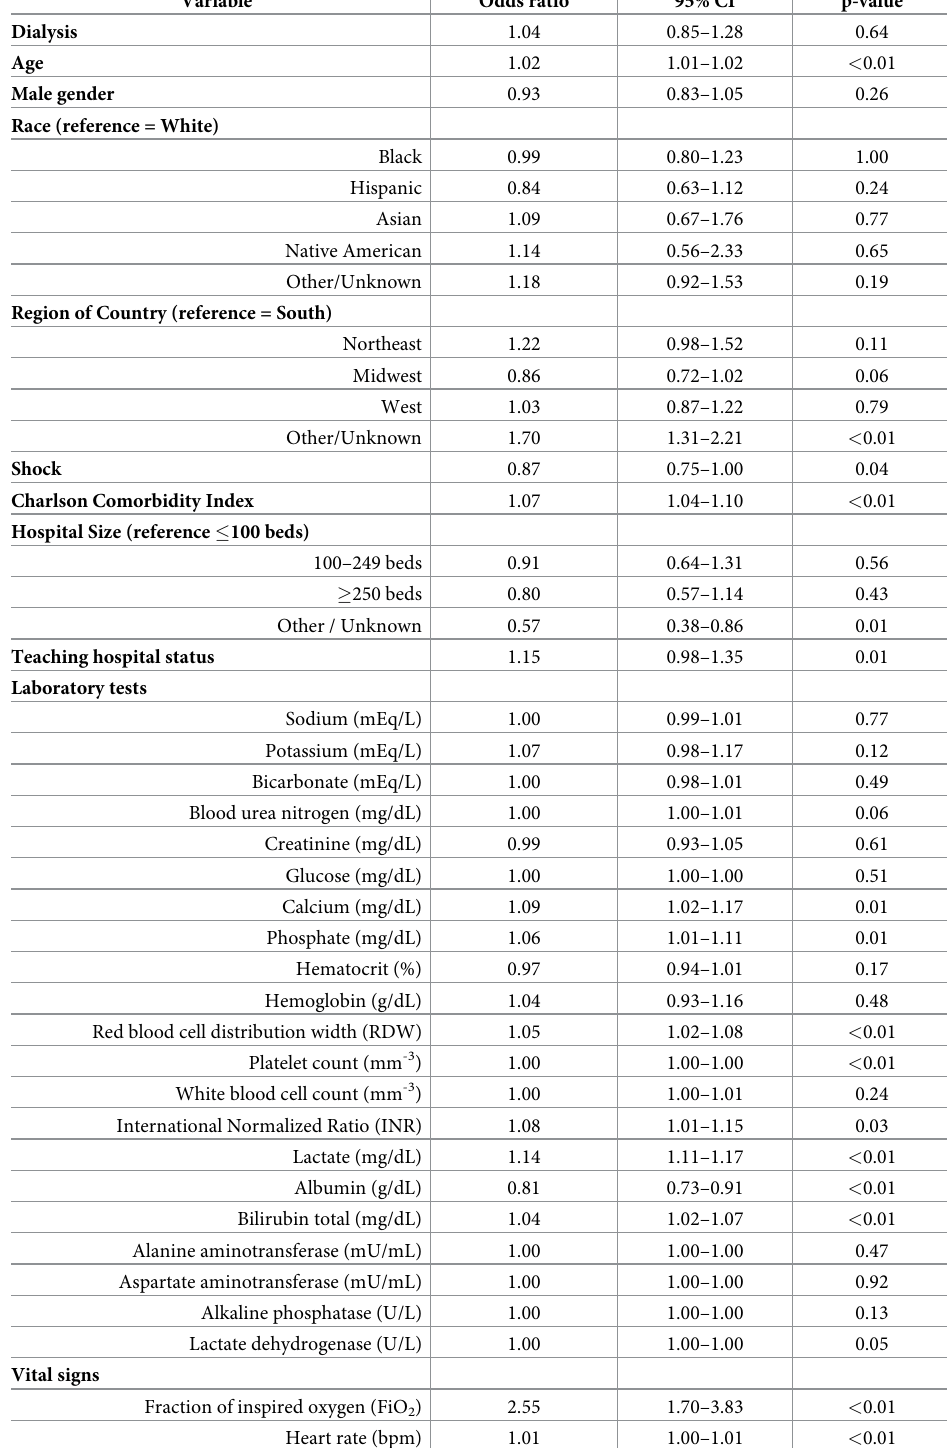
Table 3. The high resolution multivariable logistic regression model predicting in-hospital mortality in the eICU